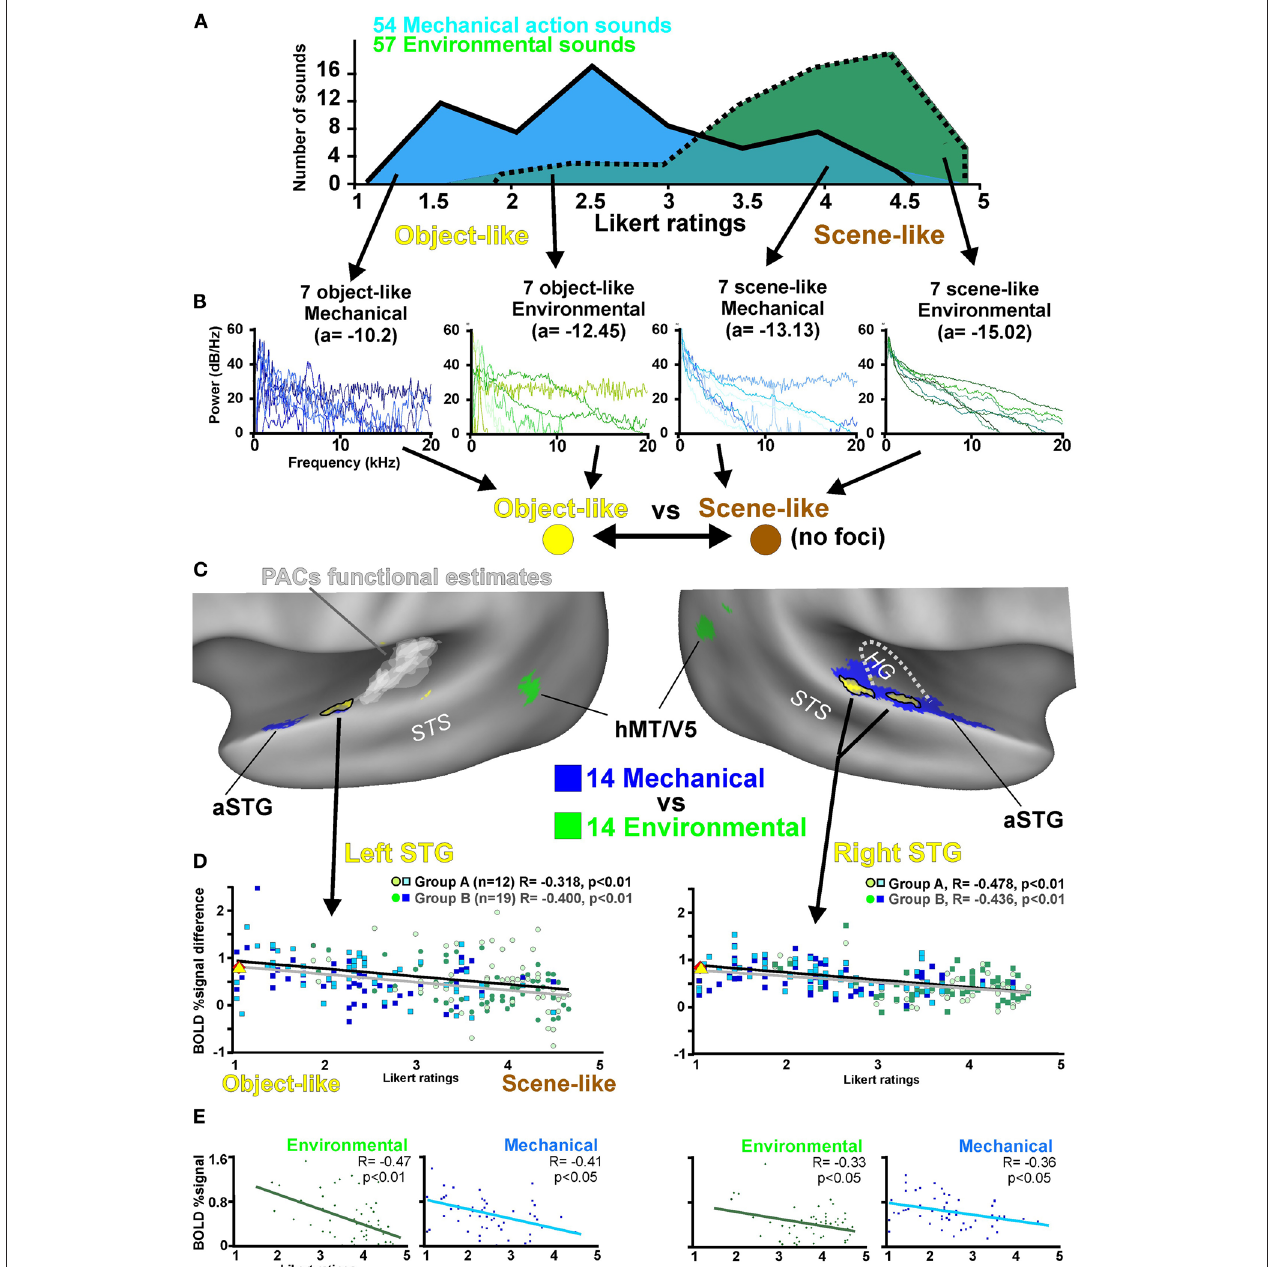
FIGURE 1 | Cortical sensitivity to the perception of auditory “objects” versus acoustic scenes, using real-world non-biological action sounds. (A) Frequency of Likert ratings (1–5) of the Mechanical (M; blue, n = 54 sounds retained) and Environmental sound stimuli (E; green, n = 57). See Table A1 bolded entries for a list of these sounds. (B) Power spectra of the 28 action sounds with the most extreme object-vs-scene ratings in each conceptual category of action sound (refer to color key). (C) Volume-based group-averaged activation common to both Groups A and B (conjunction analyses; yellow with black outlines) that showed preferential activation to sounds judged to be object-like (MO7 and EO7) versus scene-like (MS7 and ES7). Cortical responses to the same sounds were used to define regions preferential for mechanical (blue) versus environmental (green) sounds. Transparent white